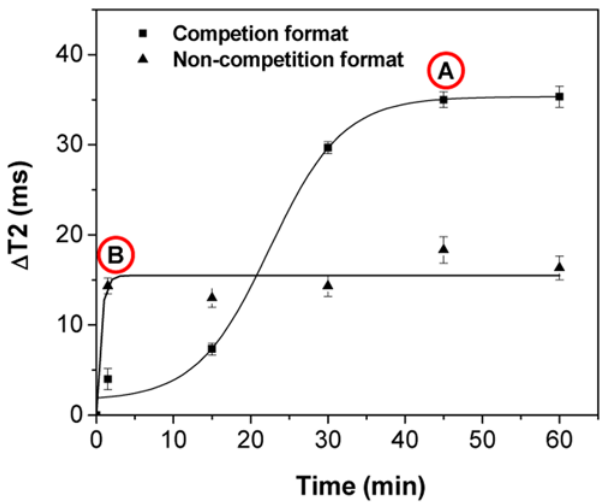
Figure 6. Kinetic profiles of the competition and non-compe- tition assay formats. Point A represents the end-point of the competition assay utilizing the dextran-coated polysaccharide nano- sensors, whereas Point B corresponds to the end-point of the non- competition assay based on the Con A-conjugated polysaccharide nanosensors.